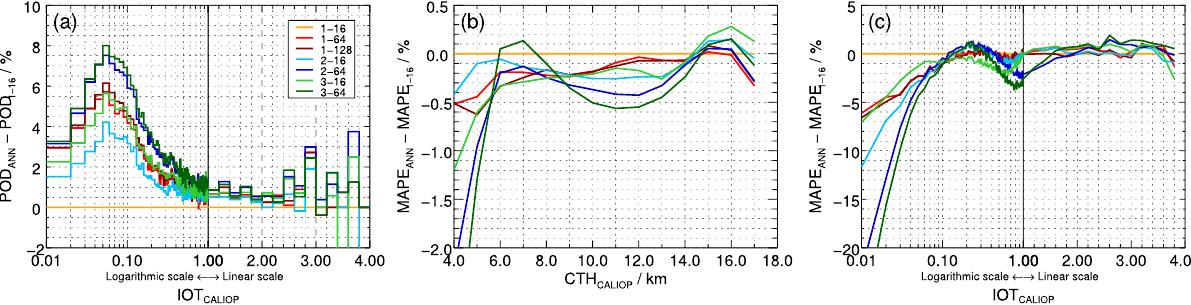
Figure 4. The difference in accuracy between each MLP structure and the least complex MLP structure having one hidden layer with 16 hidden neurons (1–16). (a) The difference in POD for the cirrus cloud detection, (b) the difference in MAPE for the CTH retrieval and (c) the difference in MAPE for the IOT retrieval. The number to the left of the hyphen is the number of hidden layers and the number to the right the number of hidden neurons per hidden